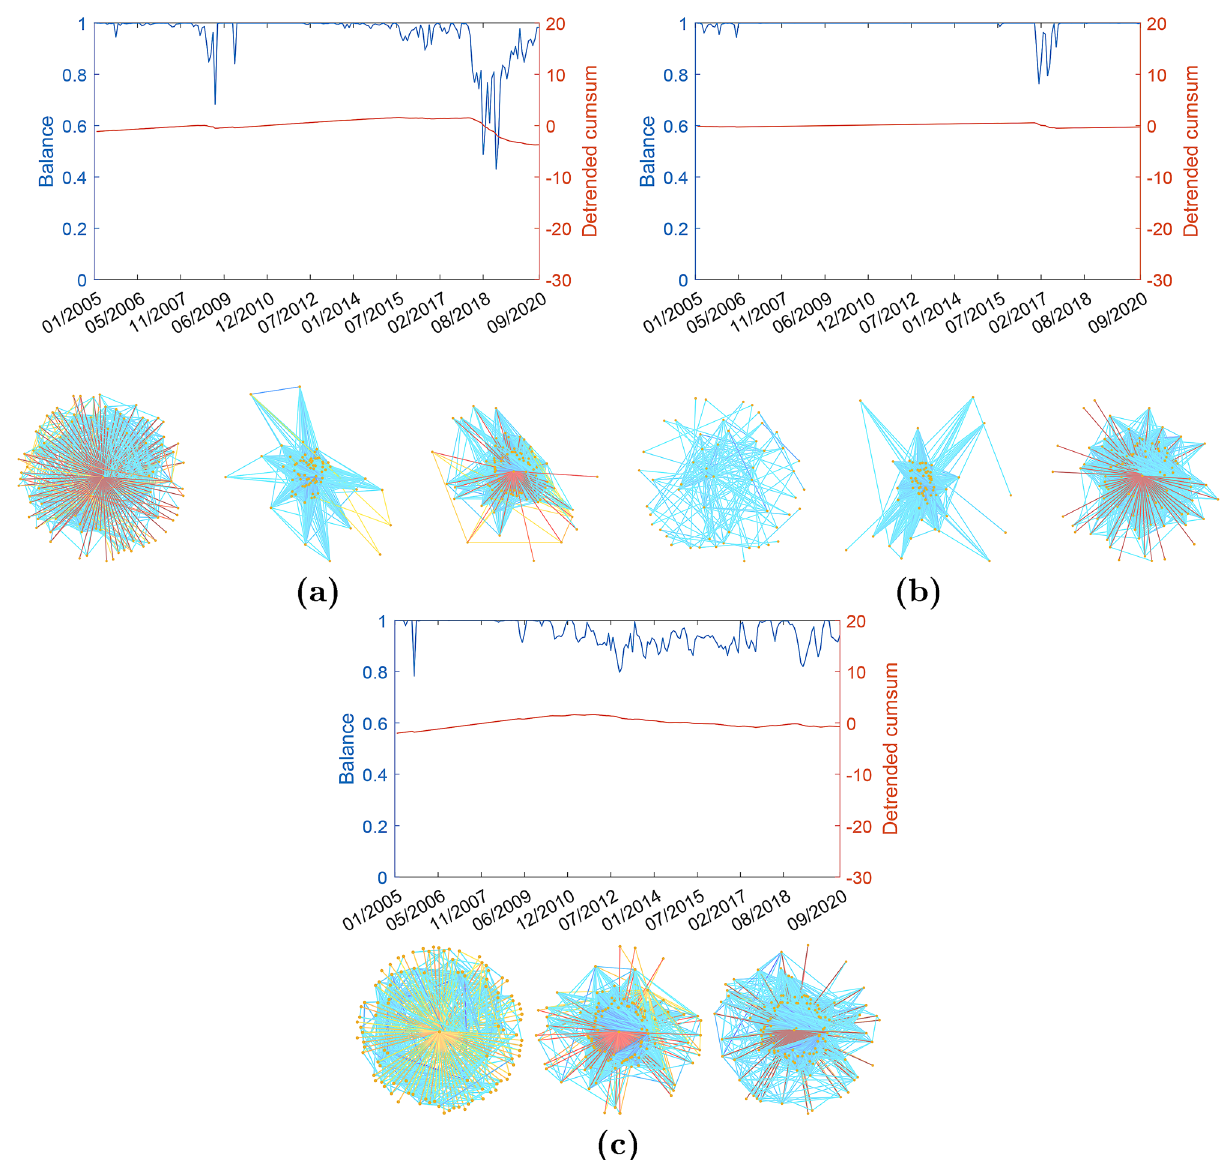
Figure 3. Balance degree evolution. ( a ) Germany. ( b ) Italy. ( c ) Japan. (Top panels) Illustration of the evolution of the balance for the period between January 2005 and September 2020 in the WSSN (blue line) and of its detrended cumulative sum (red line). (Bottom panels) Illustration of three snapshots of representative networks at different times (before, at, and after the BUT). The WSSNs are illustrated using the degree of the nodes as a proxy for the location of the nodes. The most central nodes are at the center and the low degree nodes are located at the periphery of the graph. The colors of the edges correspond to the Kendall’s tau estimates, with links going from dark red for the most negative to blue for the positive ones. In the Supplementary Information we provide Matlab images of all the networks displayed in the figure where node labels are incorporated. The reader can zoom in these networks for